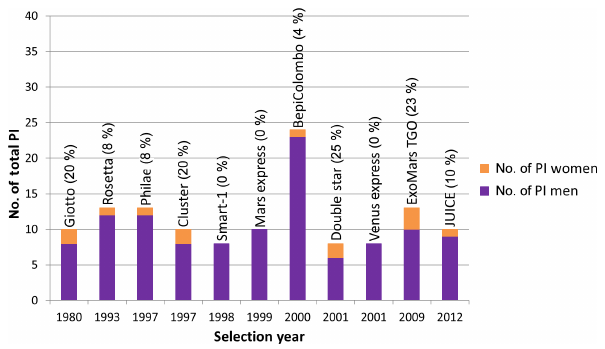
Figure 1. Number of PIs (Principal Investigators) on ESA planetary missions as a function of time. The x axis indicates the year the science mission was selected. Each bar indicates the numbers of men (purple) and women (orange) on the originally selected team on the year the team was selected. The percentage of women for each mission is indicated within